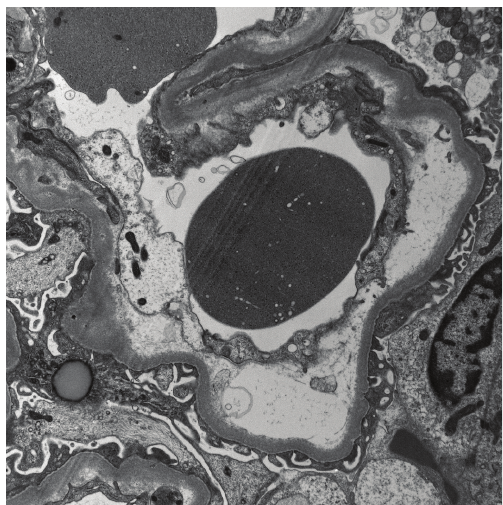
Figure 5: Electron microscopy from a patient with scleroderma renal crisis reveals detachment of the endothelium and prominent electron lucent flu ff y material (Electron microscopy; original magnification